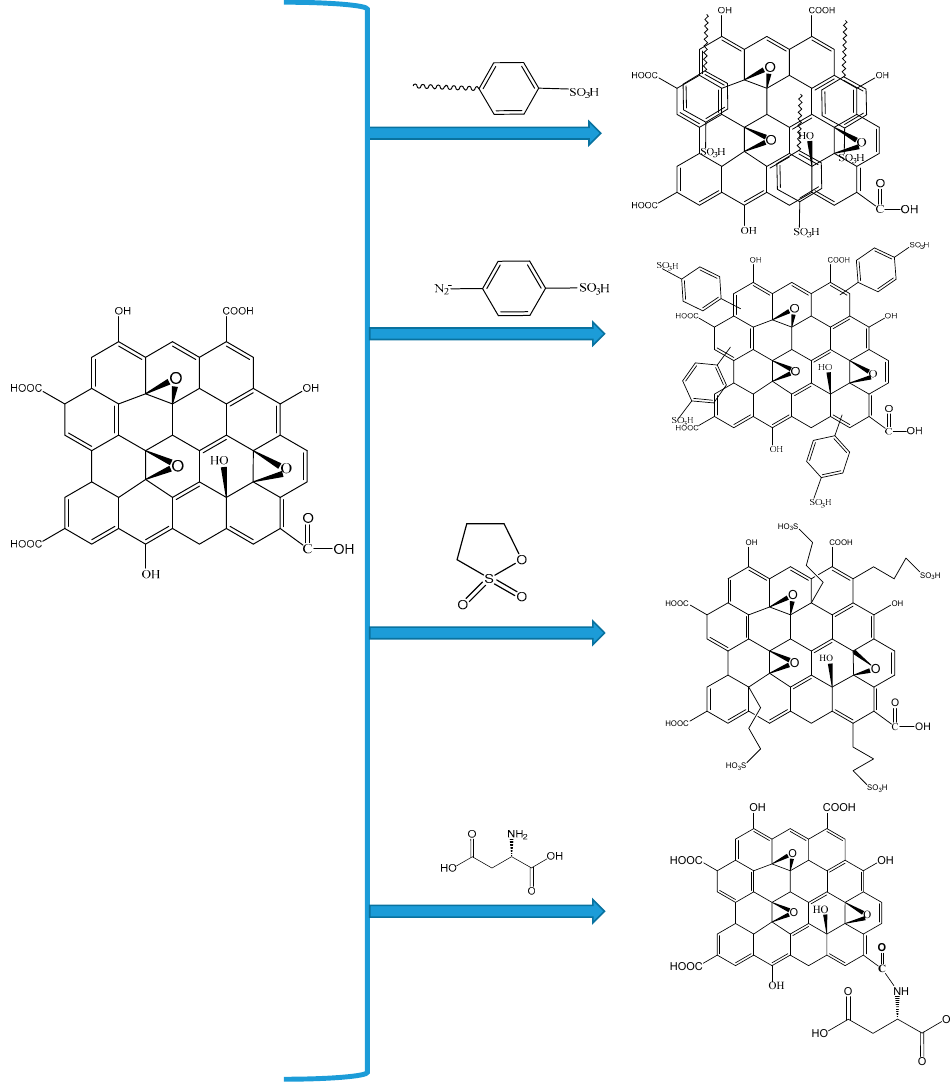
Figure 9. Di ff erent functionalization methods for Figure 9. Different functionalization methods for GO.